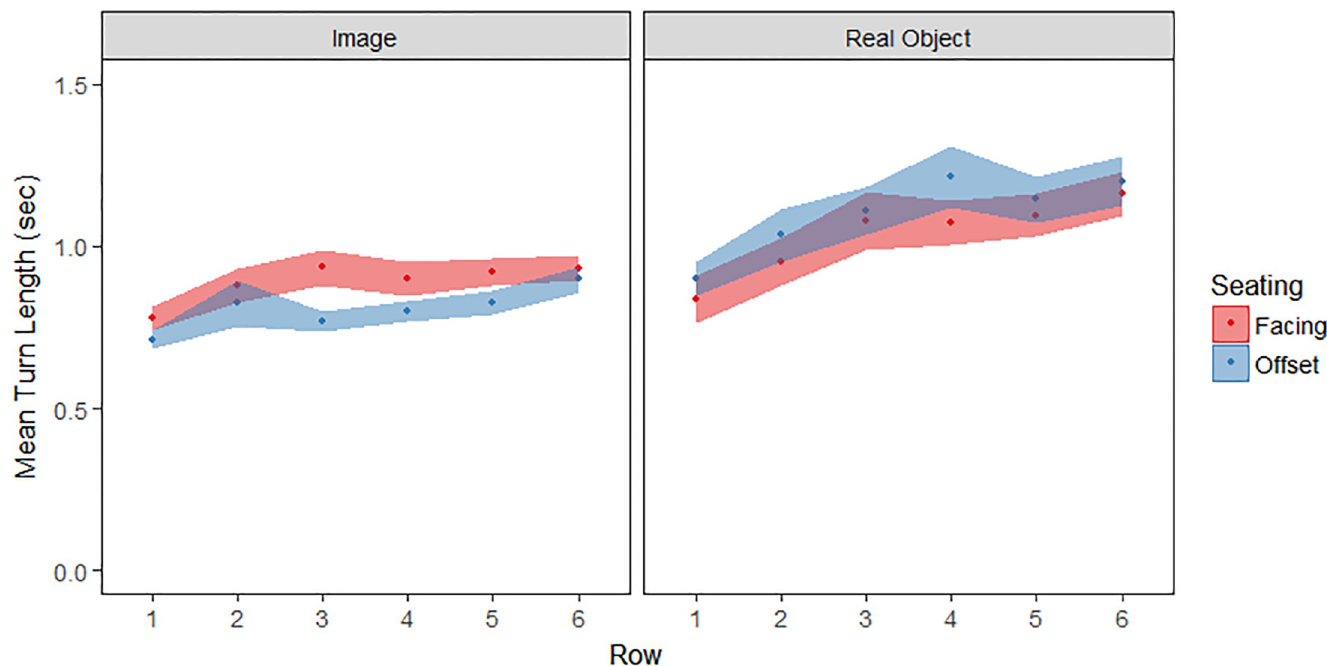
Fig 3. Mean turn duration in seconds ( M ± SE ) for moves